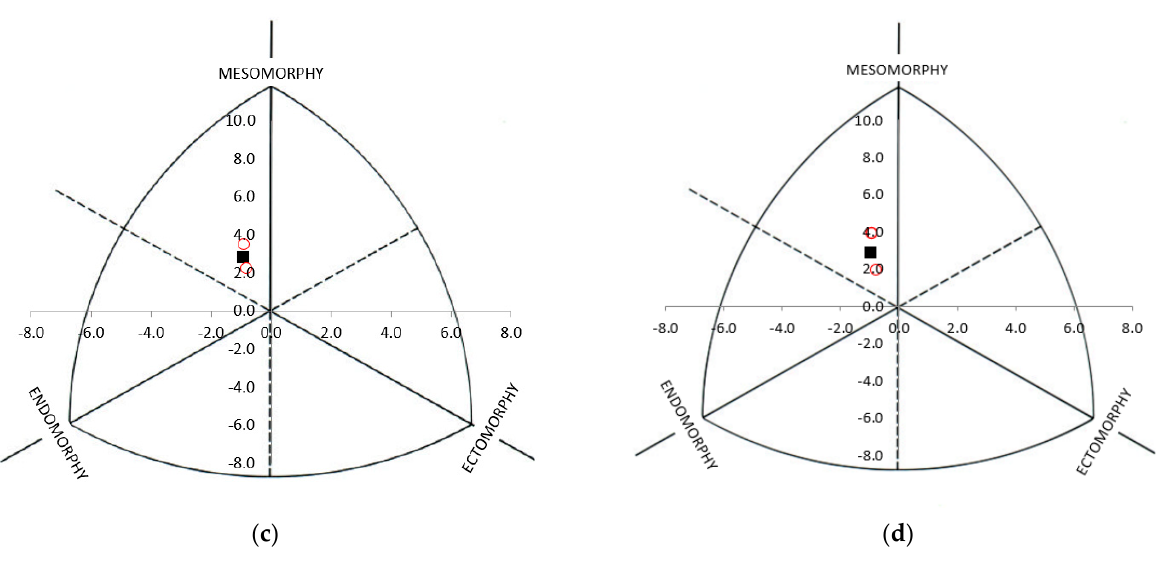
Figure 1. Somatocharts demonstrating: ( a ) distribution of somatotype for study participants (n = 68); ( b ) mean somatotype for population with RTEM mean ranges; ( c ) Mean somatotype for population with L23TEM mean ranges; ( d ) Mean somatotype for population with L1TEM mean ranges. ▪ = pop- ulation mean. O = RTEM 95% confidence intervals. Table 1. Percentage of participants potentially mis-classified based on 95%